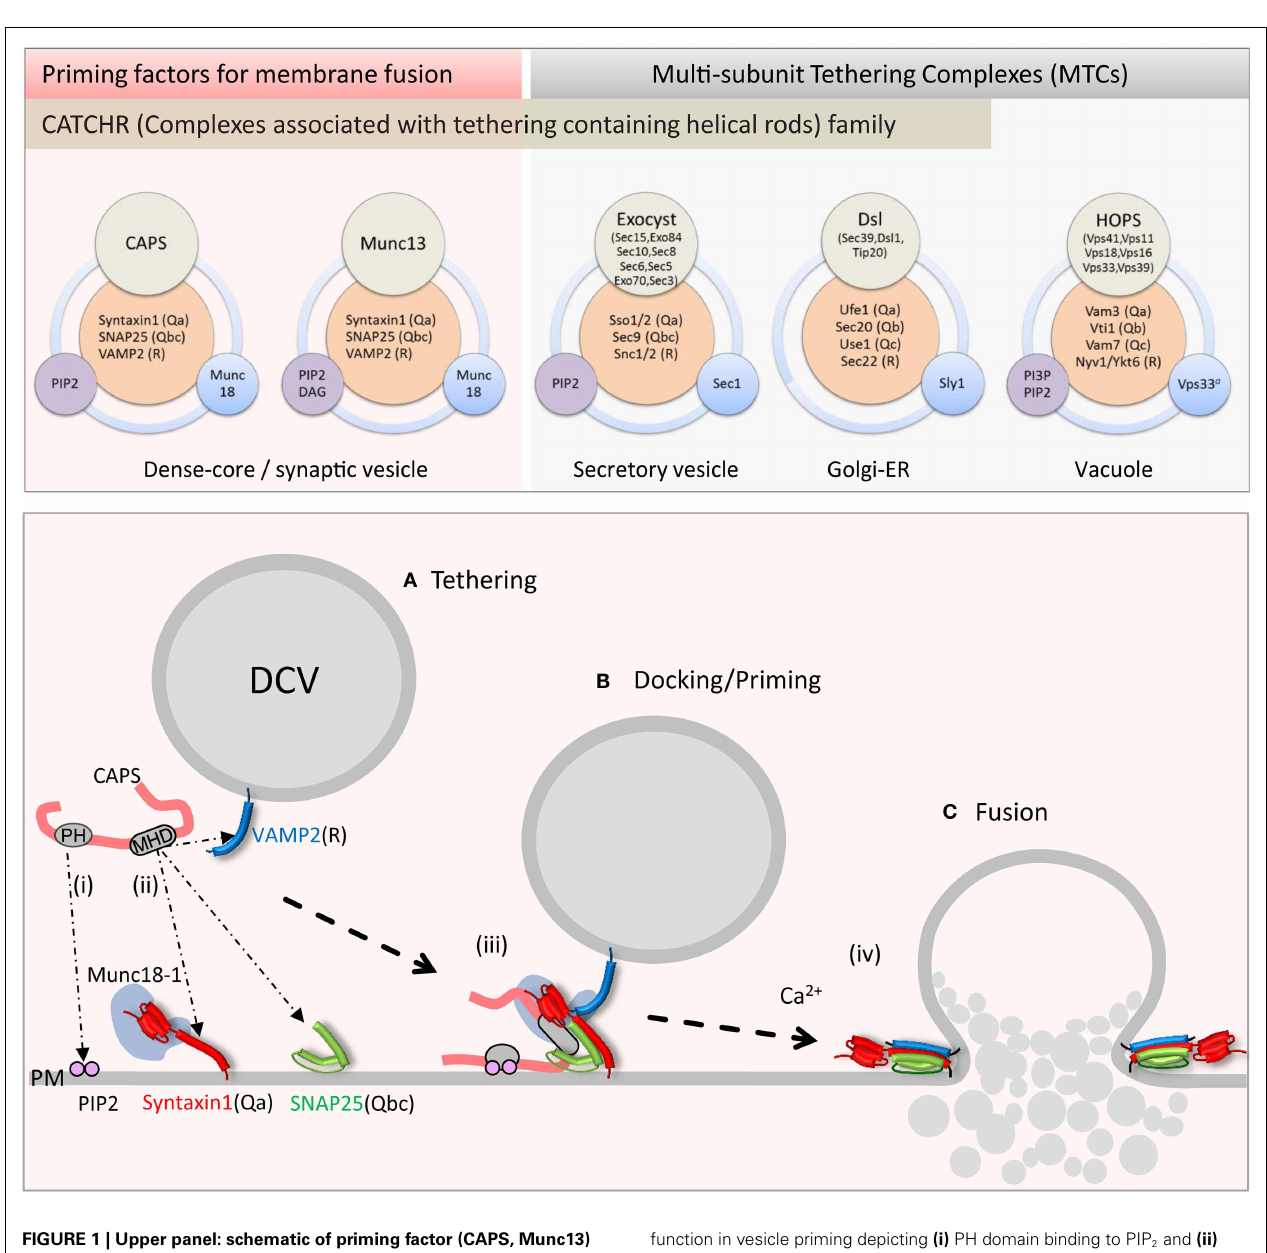
FIGURE 1 | Upper panel: schematic of priming factor (CAPS, Munc13) and tethering complex (exocyst, Dsl1, HOPS) composition and interactions . Multi-domain CAPS and Munc13 proteins interact with neuronal SNAREs and PIP 2 and co-function with the SM Munc18-1.The exocyst complex with eight subunits interacts with cognate SNAREs, PIP 2 , and the SM Sec1.The Dsl1 complex with three subunits interacts with cognate SNAREs and co-functions with the SM protein Sly1.The HOPS complex with six subunits interacts with cognate SNAREs, PI3P, and PIP 2 , and contains the SM proteinVps33. Lower panel: schematic of CAPS